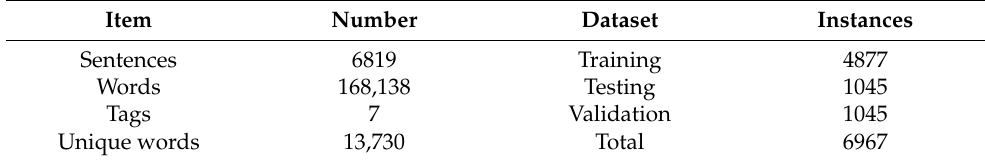
Table 2. Extracted dataset details.